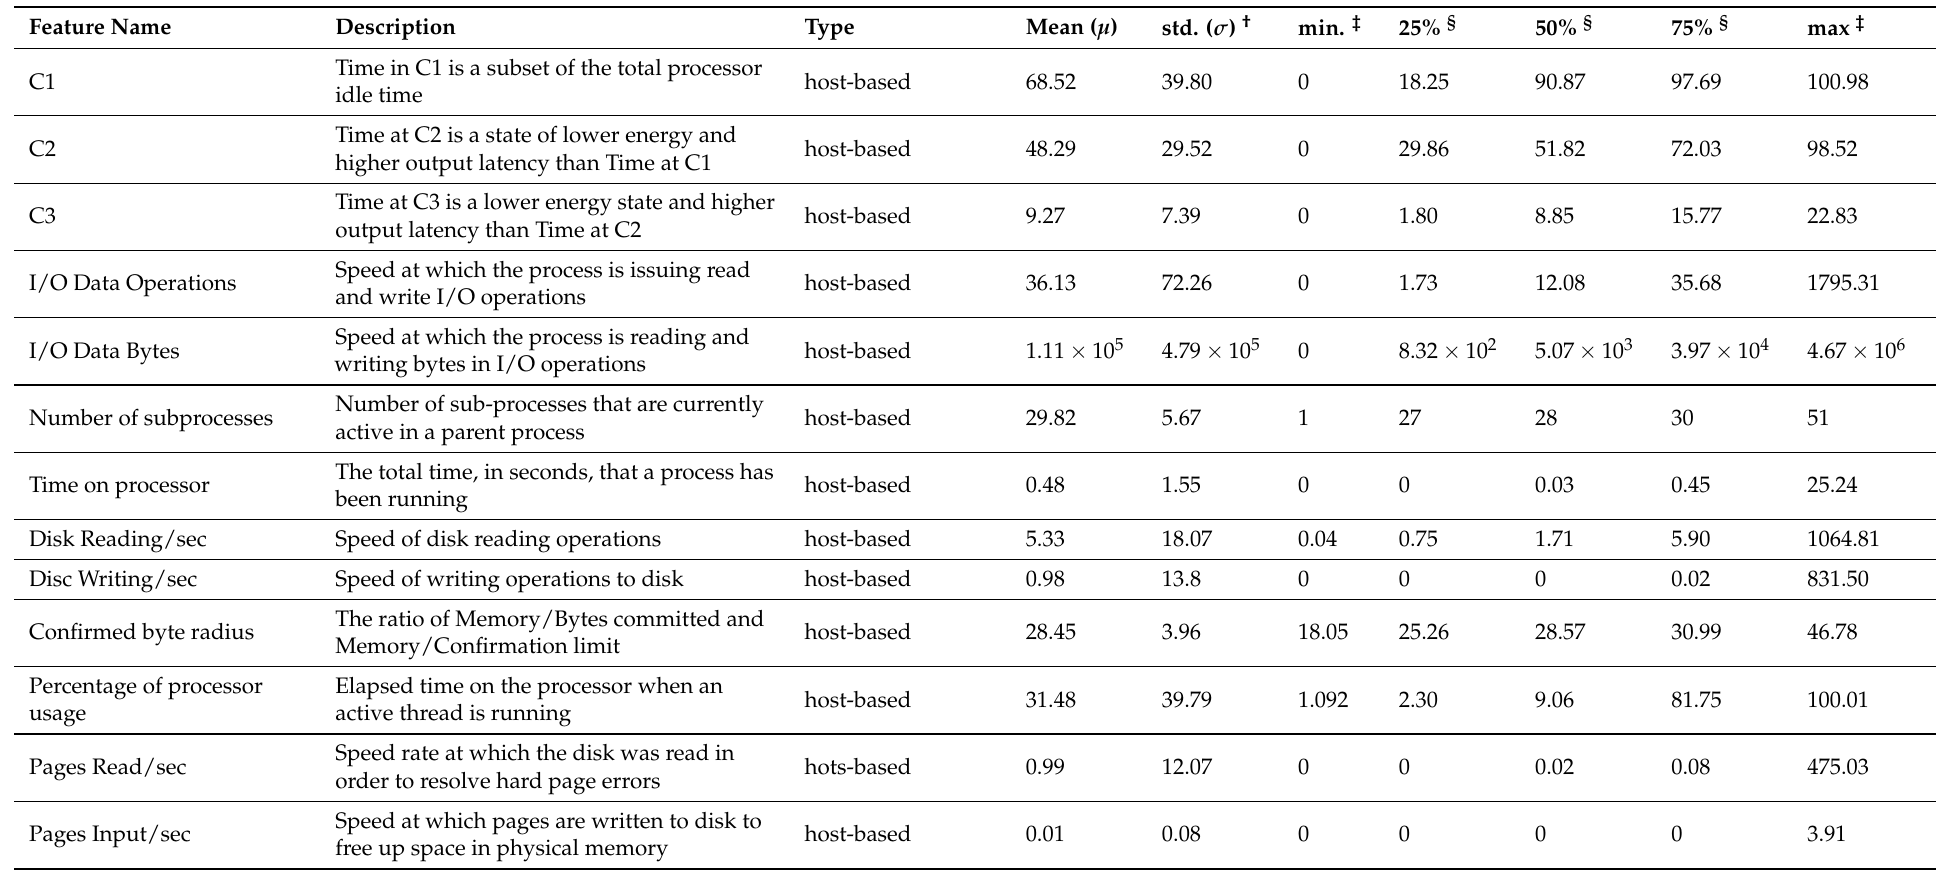
Table 3. Features comprising the data